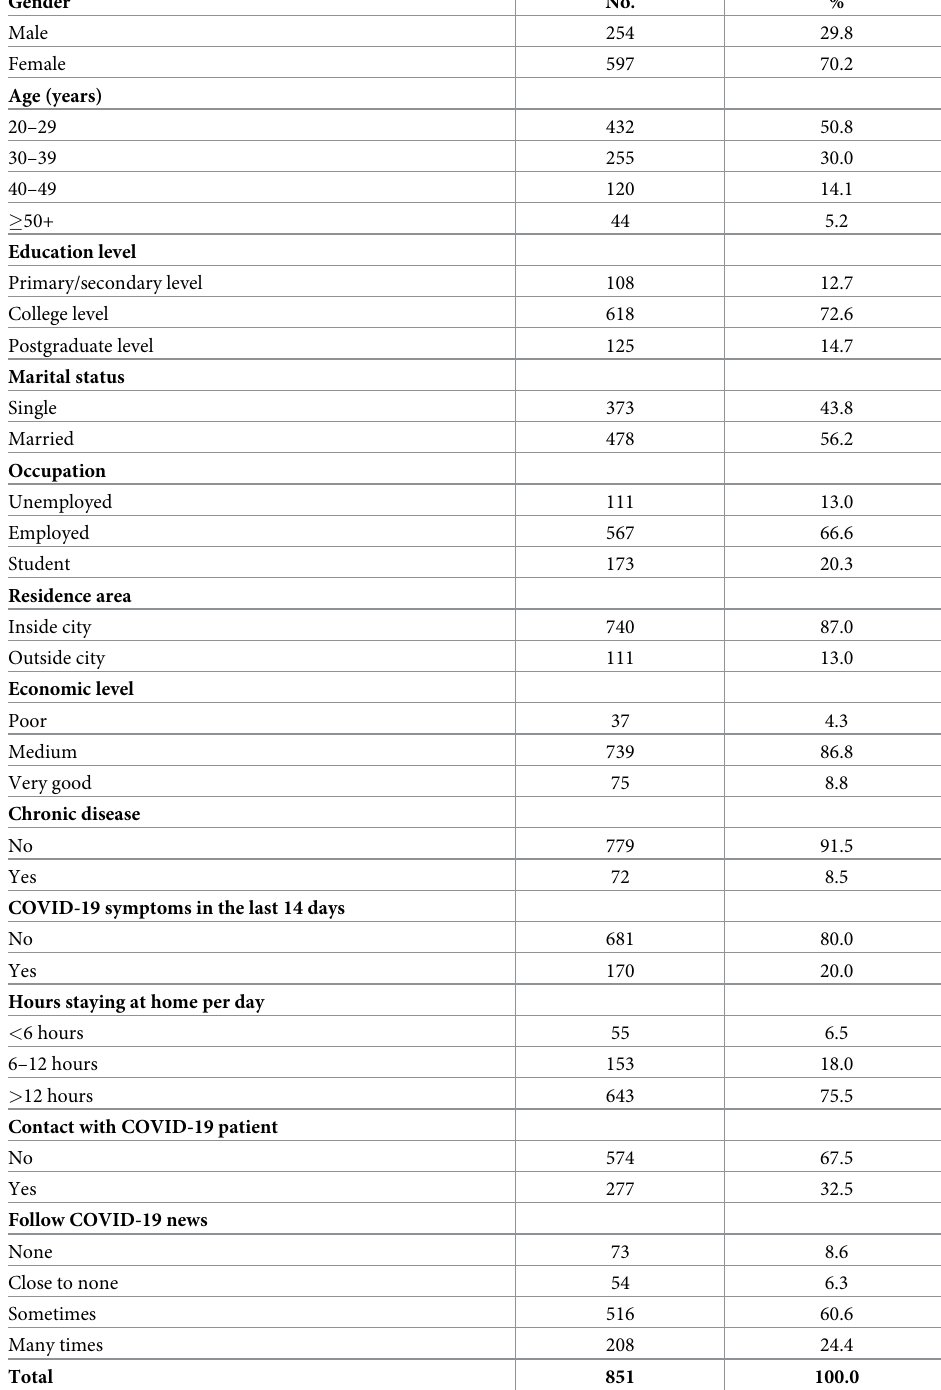
Table 1. Sociodemographic and clinical characteristics of the